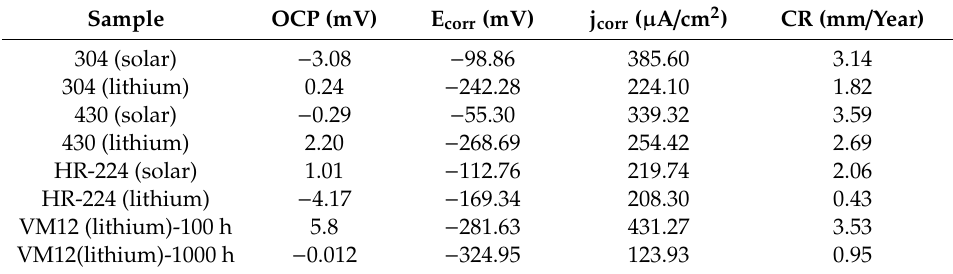
Table 11. Corrosion data of tested 304, 430 and HR-224 in KNaNO 3 (solar salt) and LiNaKNO 3 (ternary salt with lithium content) at 550 ◦ C.